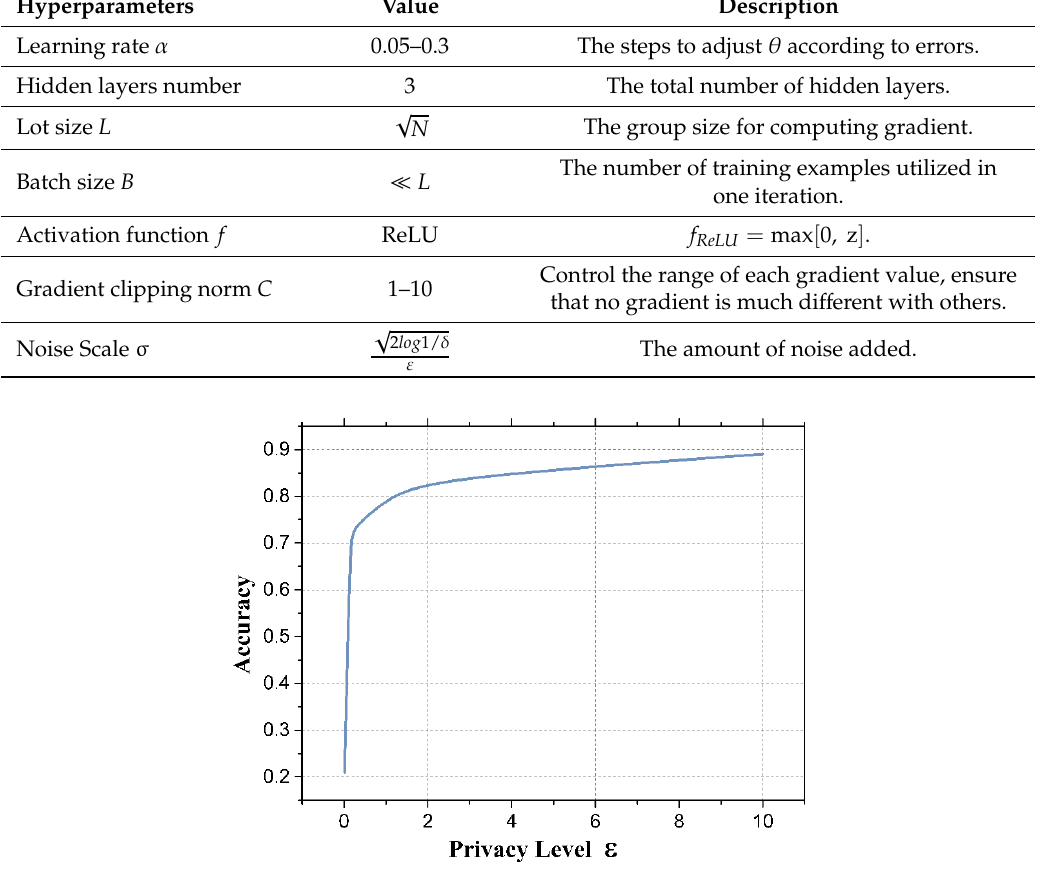
Figure A2. Privacy–accuracy curve of privacy-preserving NILM (Data from [73]) .